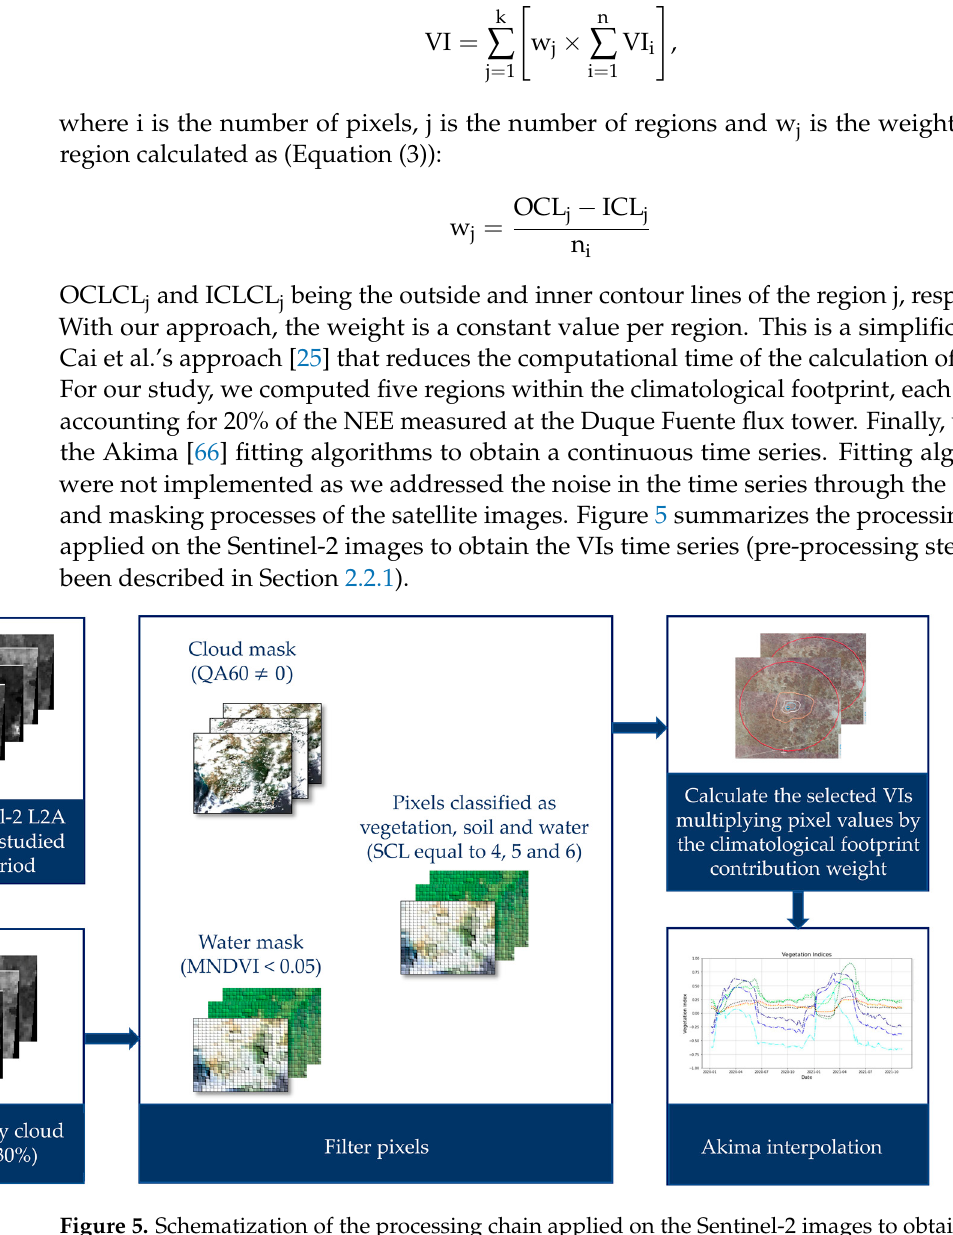
Figure 5. Schematization of the processing chain applied on the Sentinel-2 images to obtain the VIs time series. At first, S2 L2A images (with orthorectification and atmospheric correction) are collected and filtered by cloud coverage (<30%). Then, pixels are filtered using (i) the supplementary band QA60 to mask the clouds; (ii) the SCL band to select pixels classified as vegetation, soil and water and (iii) a water mask to remove flooded pixels without standing vegetation (MNDVI < 0.05). Finally, the VI is calculated for each pixel within the climatological footprint, multiplied by their contribution weight and summed to obtain the final VI, a single value of VI per image per day. The Akima fitting algorithm is then applied to fill in the gaps and obtain a continuous time series.